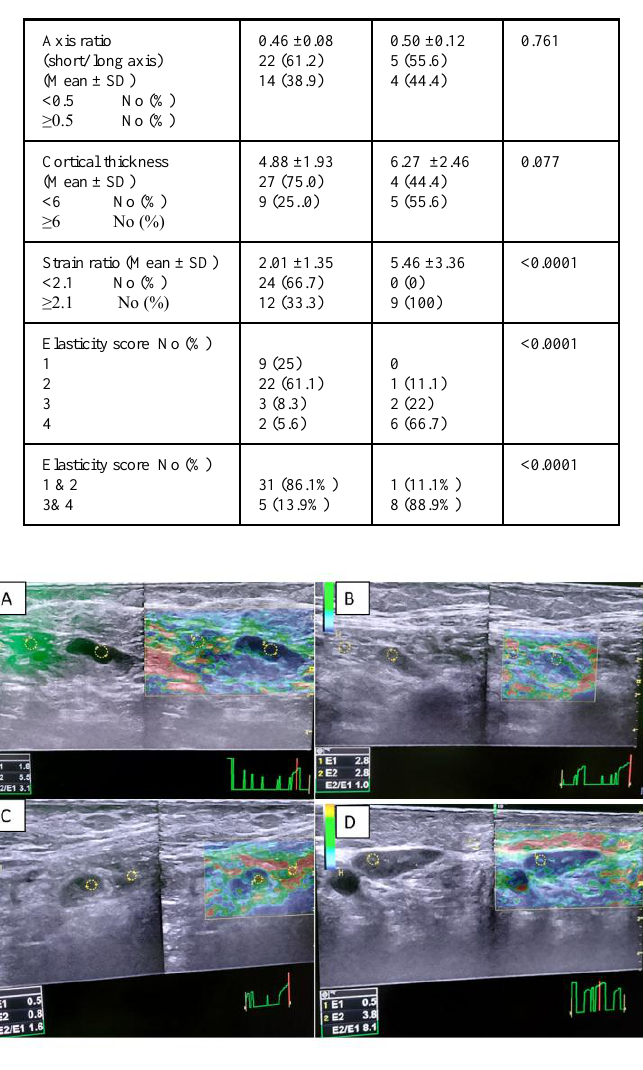
Figure 1 Elastography study of axillary lymph nodes. A) A patient with newly diagnosed breast cancer had enlarged ipsilateral axillary LN, elasticity score was 3, strain ratio was 3.1, FNA revealed malignancy that was proved after excisional biopsy. B) A patient complained of left axillary pain, the ultrasound revealed an infected sebaceous cyst with an ipsilateral enlarged axillary lymph node, elasticity score 2 and the strain ratio was 1, cytology impression was reactive, reduction in cortical thickness was noted at the follow up visit. C) A patient complained of a palpable lump at the left axilla after COVID 19 vaccination, the ultrasound revealed left axillary lymphadenopathy with an elasticity score of 2 and a strain ratio of 1.6, the cytology impression was reactive, reduction in cortical thickness was noted at the follow up visit. D) A patient complained of right axillary pain, ultrasound revealed right axillary lymphadenopathy with an elasticity score of 3 and the strain ratio of 8.1 with no ipsilateral breast abnormality. The radiological impression was suspicious, cytology revealed reactive lymphadenopathy confirmed by excisional biopsy (False positive). ROC curve was used to investigate the utility of SR as a diagnostic tool. The area under the curve (AUC) was 0.906 with a 95% CI of 0.814-0.997, P<0.001, Figure 2. By reviewing the sensitivity and the specificity of the different cutoff values, we found that SR